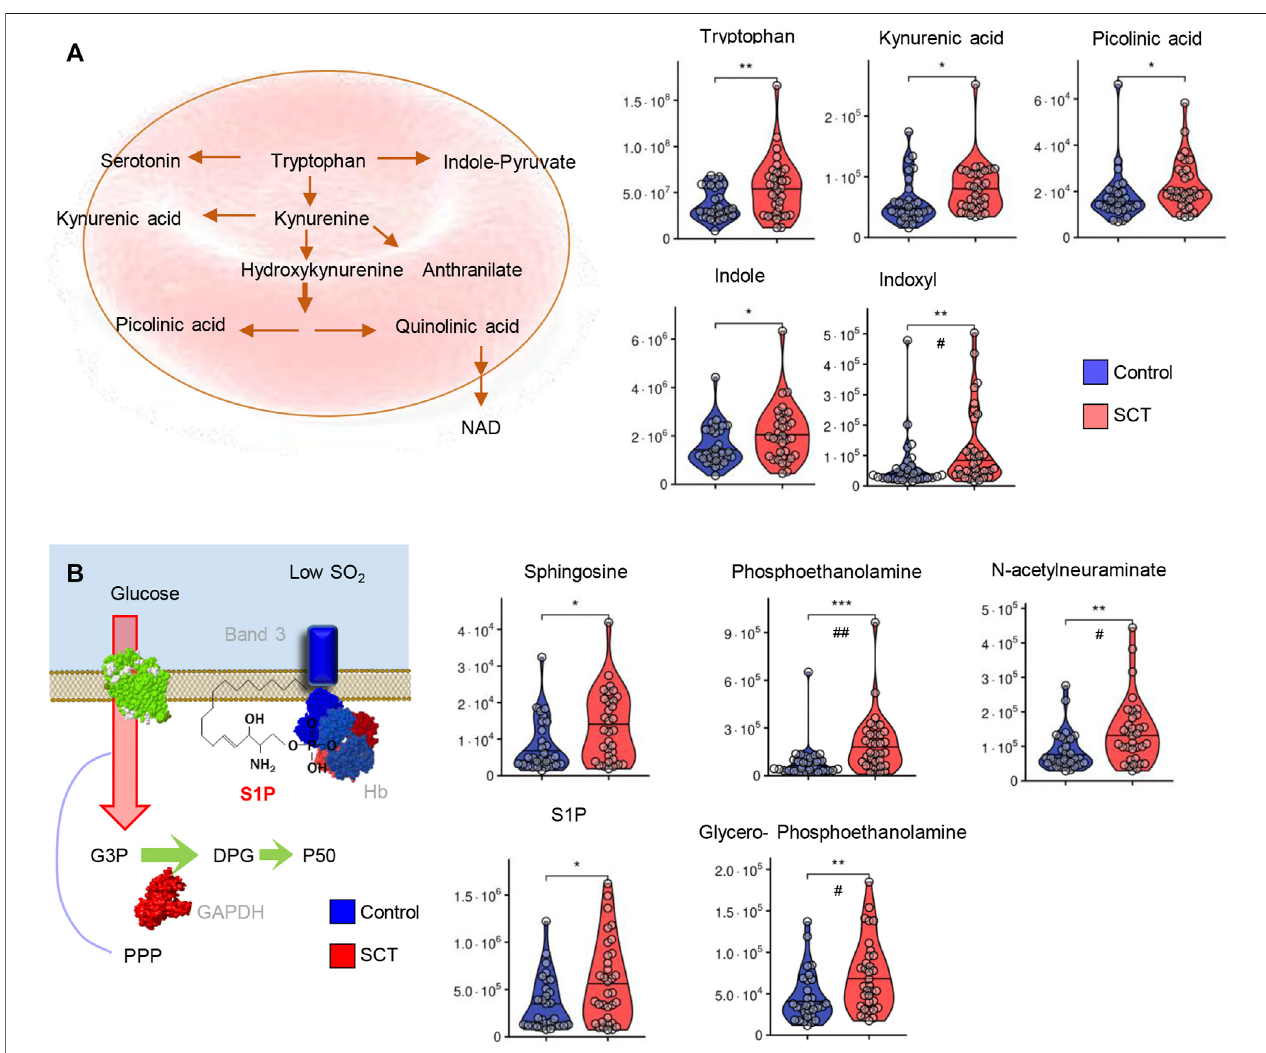
FIGURE 7 | Overview of tryptophan metabolism (A) and sphingolipid metabolism (B) in plasma from control (blue) and sickle cell trait (red) subjects. Asterisks indicate signi fi cance (* p < 0.05; ** p < 0.01; *** p < 0.001 Wilcoxon/Mann-Whitney U -test). FDR-corrected p -values are provided for all analytes in Supplementary Table S1 and indicated with # using the same signi fi cance ranges as per the asterisks in p -values above.